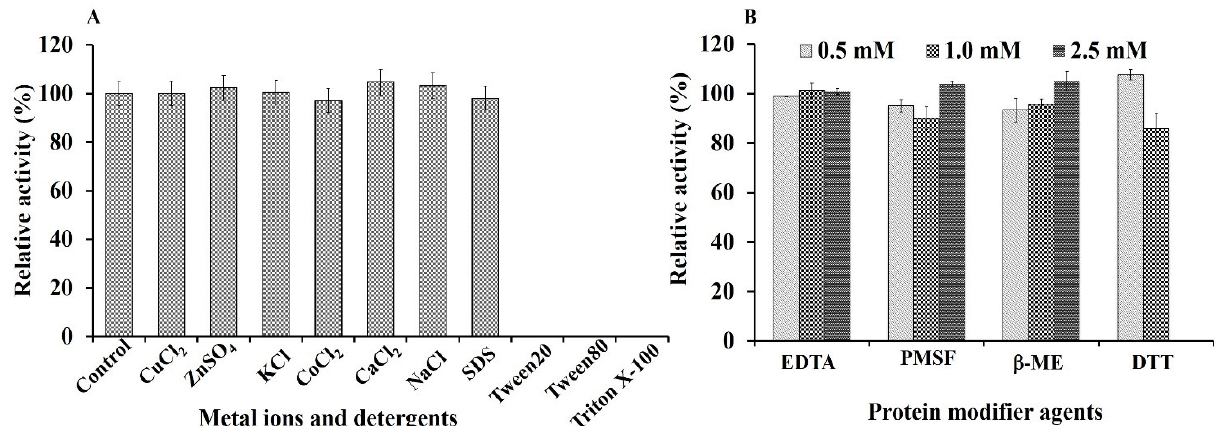
Figure 5. Effect of metal ions, detergents, and protein modifier agents on Pg -ASNase II activity. ( A ) The enzyme was incubated with 1.0 mM CuCl 2 , ZnSO 4 , KCl, CoCl 2 , CaCl 2 , and NaCl and 2.0% of SDS, Tween 20, Tween 80, and Triton X-100. The relative activity was calculated by considering the 100% activity of the enzyme without the addition of metal ions (control). ( B ) Protein modifier agents such as EDTA, PMSF, β-ME, and DTT were used at different concentrations of 0.5, 1.0, and 2.5 mM to assess the residual activity of Pg -ASNase II. The error bar represents the standard deviation of three experiments.